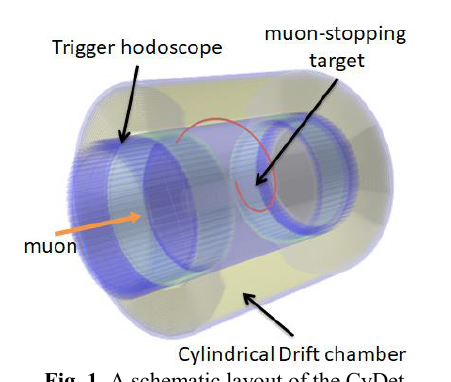
Fig. 1. A schematic layout of the CyDet.